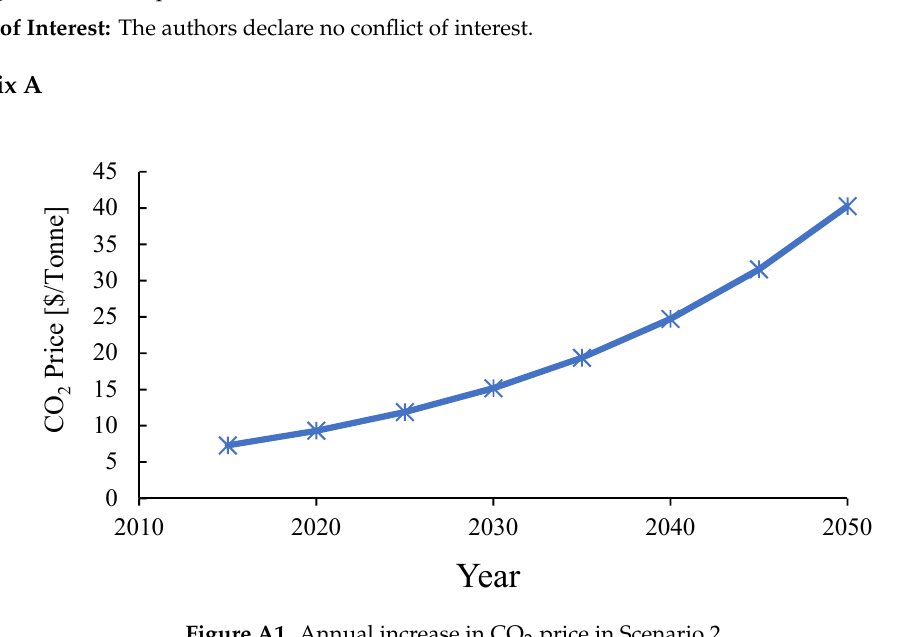
Figure A1. Annual increase in CO 2 price in Scenario 2